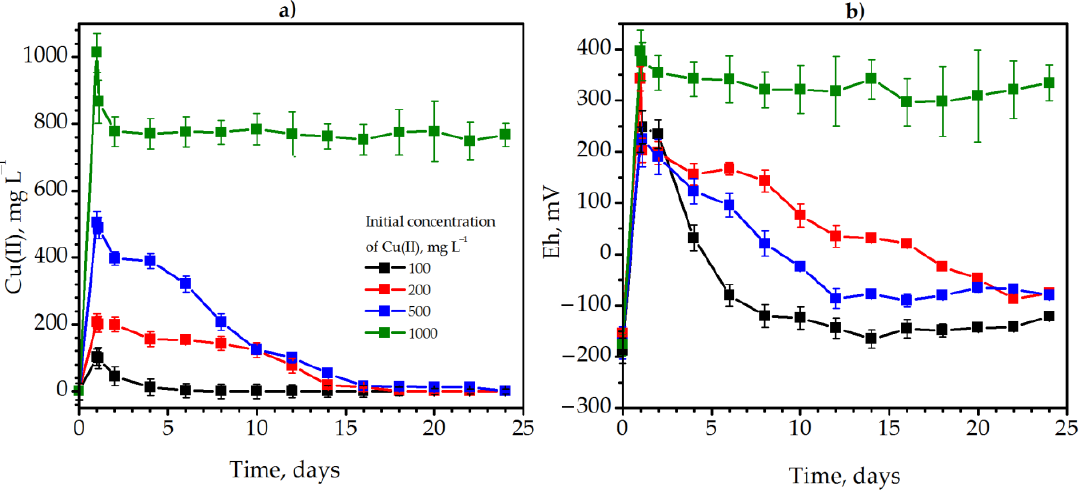
Figure 2. The dynamics of the Cu(II) detoxification ( a ) and Eh ( b ) during methane degradation of Solidago canadensis L. weed at the presence of 100 (black lines), 200 (red lines), 500 (blue lines), and 1000 (green lines) mg L − 1 Cu(II): The black lines represent the value of the redox potential. The duration of detoxification was 24 days with 100% efficiency. In contrast to the previous variants, increasing the concentration of Cu(II) to 1000 mg L − 1 had a detrimental effect on the anaerobic microbial community (Figure 2a, green lines). In two days, the concentration of soluble Cu(II) decreased only from 1013.5 to 777.5 mg L − 1 (Figure 2a, green lines). Later, the copper concentration did not change, and the immobilization efficiency was only 23.3%.